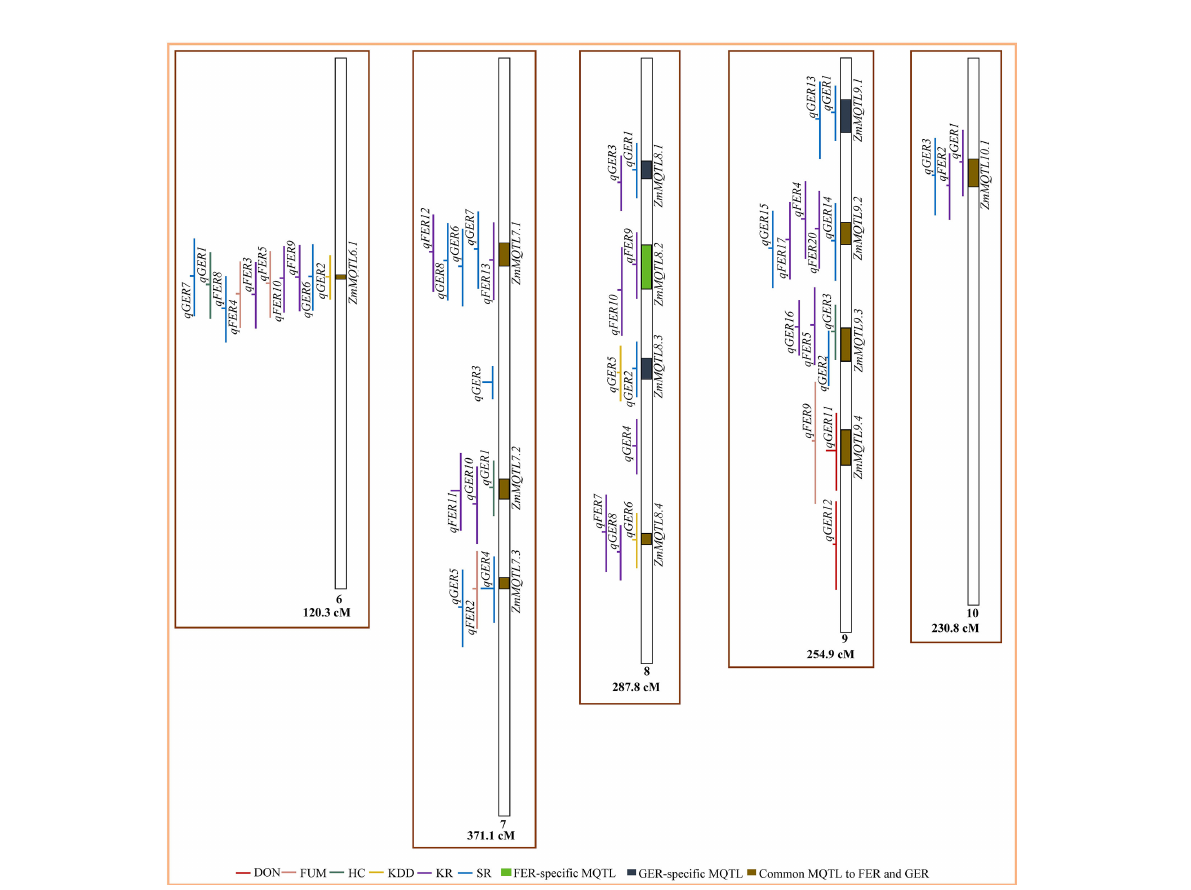
FIGURE 3 Colocalization of QTL for Fusarium ear rot (FER) and Gibberella ear rot (GER) and identi fi cation of meta-QTL (MQTL) on chromosomes 6 ‒ 10. The line in the middle of each QTL represents its LOD score in the original work. The longer this line, the higher the LOD score of the respective QTL. DON, deoxynivalenol accumulation; FUM, fumonisin accumulation; HC, husk coverage; KDD, kernel dry-down rate; KR, kernel resistance; SR, silk